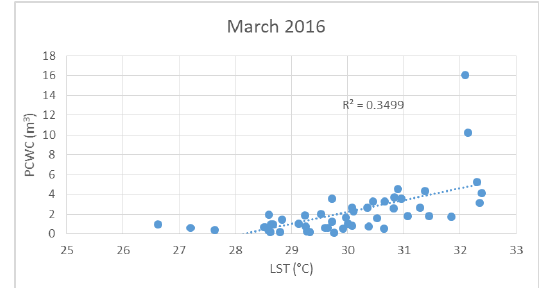
Figure 5. Correlation of LST and PCWC for the month of